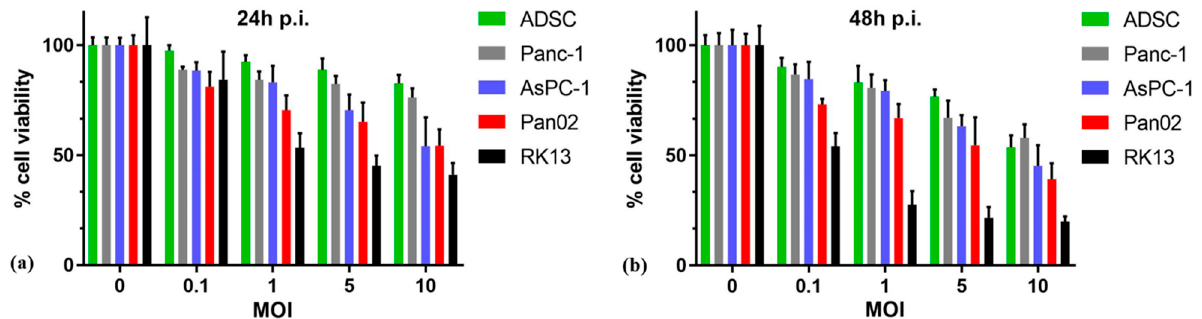
Figure 3. MYXV infection reduces the viability of pancreatic cancer cells. Pancreatic cancer cell (Panc-1, AsPC-1 and Pan02) ADSCs, as well as RK13 (1 × 10 4 cells/well), were infected with vMyx-mLIGHT-FLuc/tdTr at four various MOIs (0.1; 1; 5 and 10) and analyzed for cell viability using the MTS assay at ( a ) 24 h and ( b ) 48 h post-infection. The assays were performed in triplicate; error bars shown are means ± SD.